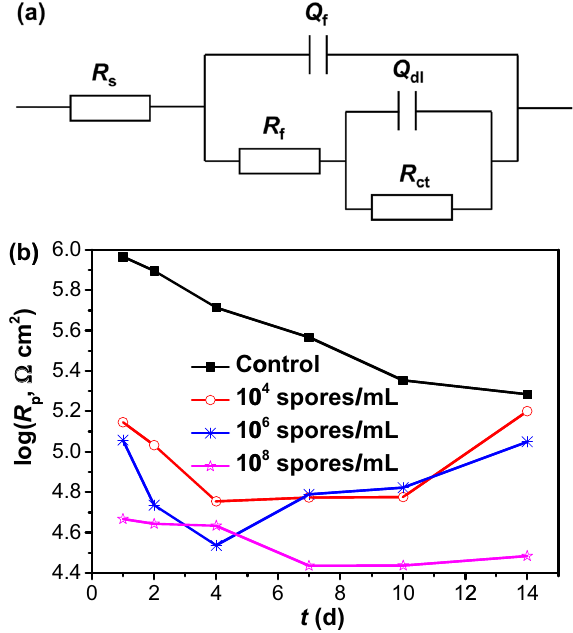
Fig. 5 The electrochemical equivalent circuit and the fi tted results of EIS data. a electrochemical equivalent circuit, b changes of R p , i.e., R f + R ct , fi tted from the EIS data in Fig. 5 with time.